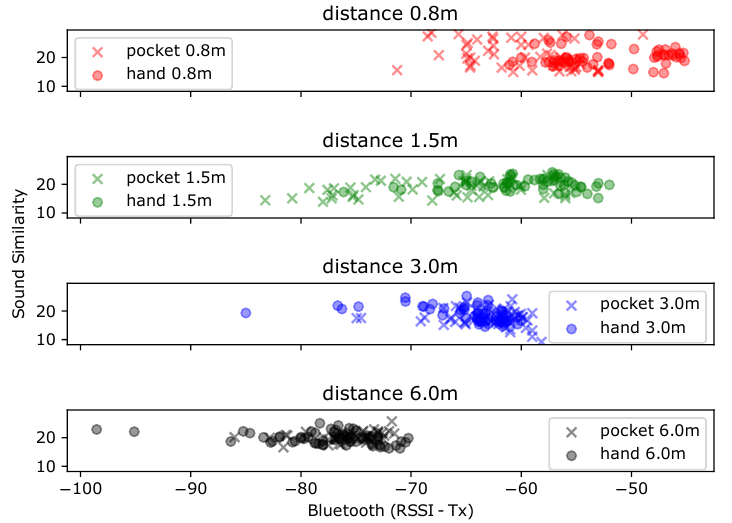
Figure 7. Distribution of features for our pocket versus hand experiment. We can see that there is overlap in Bluetooth readings for different distances and that phone placement can influence them too. Sound similarity, on the other hand, is more consistent with a difference in range only when very close (0.8